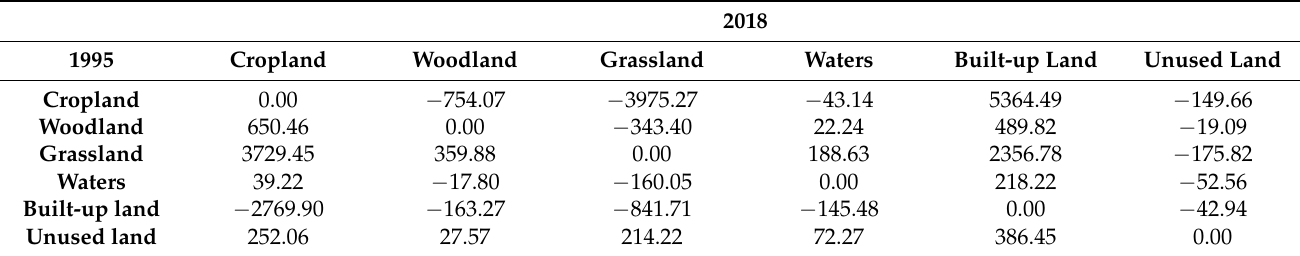
Table 5. Land use economic benefit change caused by land use change (hundred million yuan).